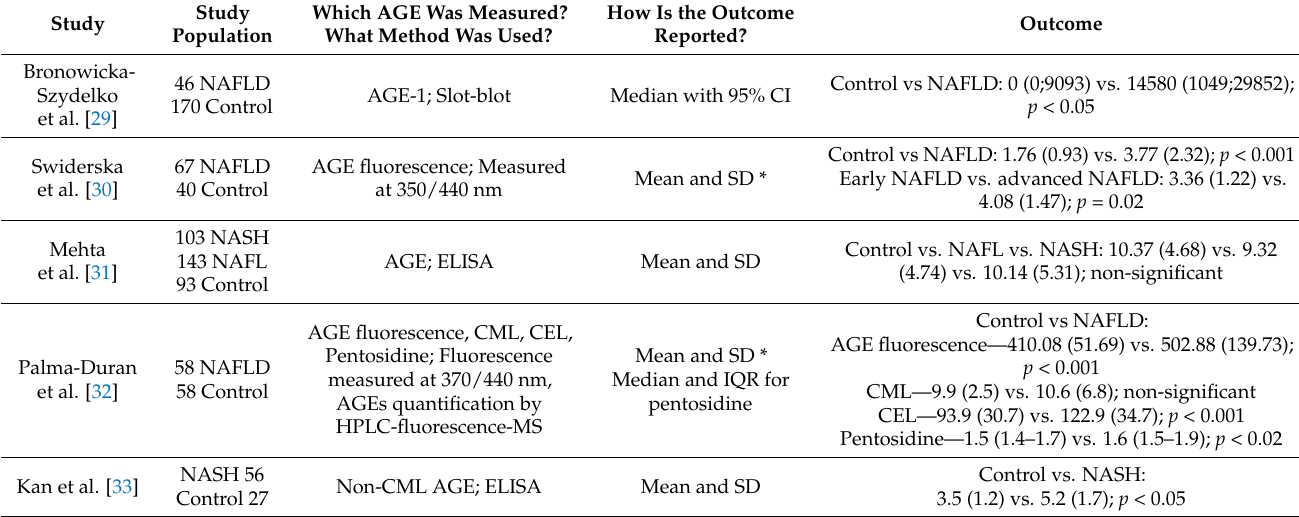
Table 1. Characteristics of the included